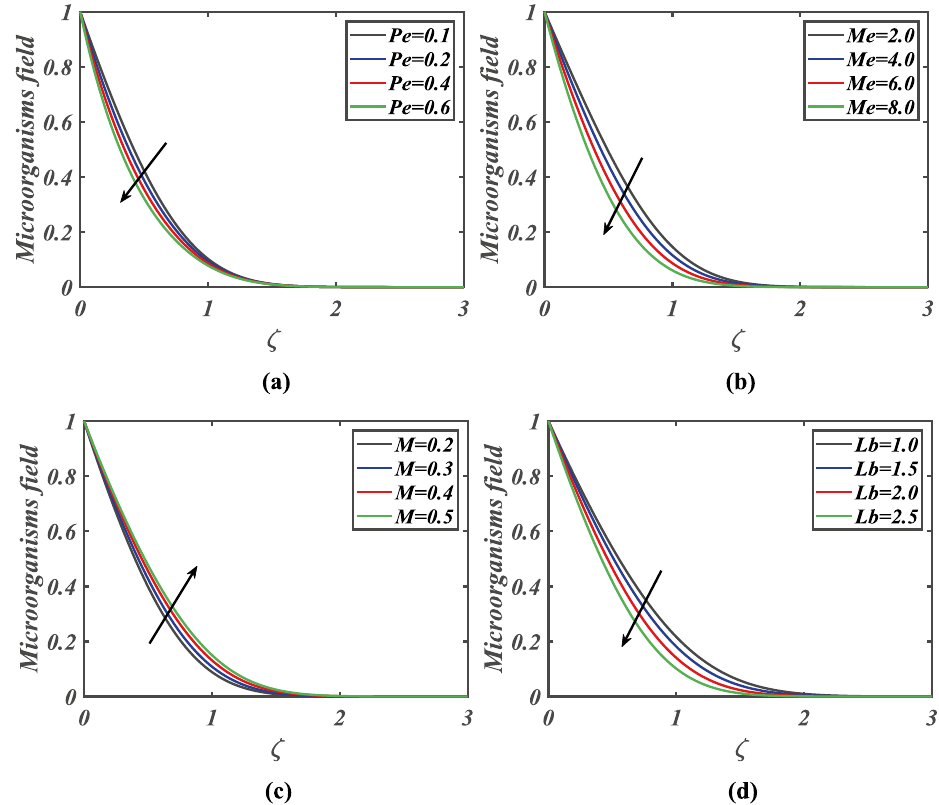
Figure 5. (a)–(d) Response of microorganisms χ against varied values of Pe , Me , M and Lb .